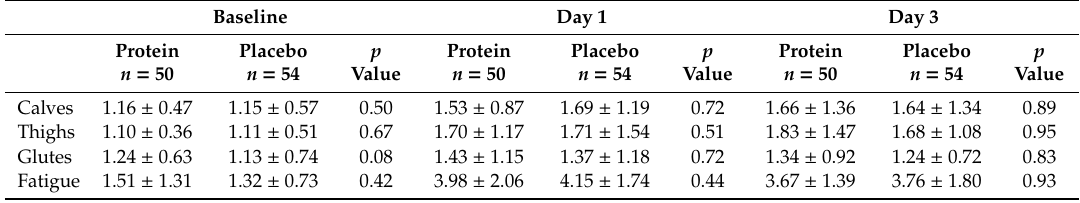
Table 3. Muscle soreness and fatigue during moderate-intensity exercise.